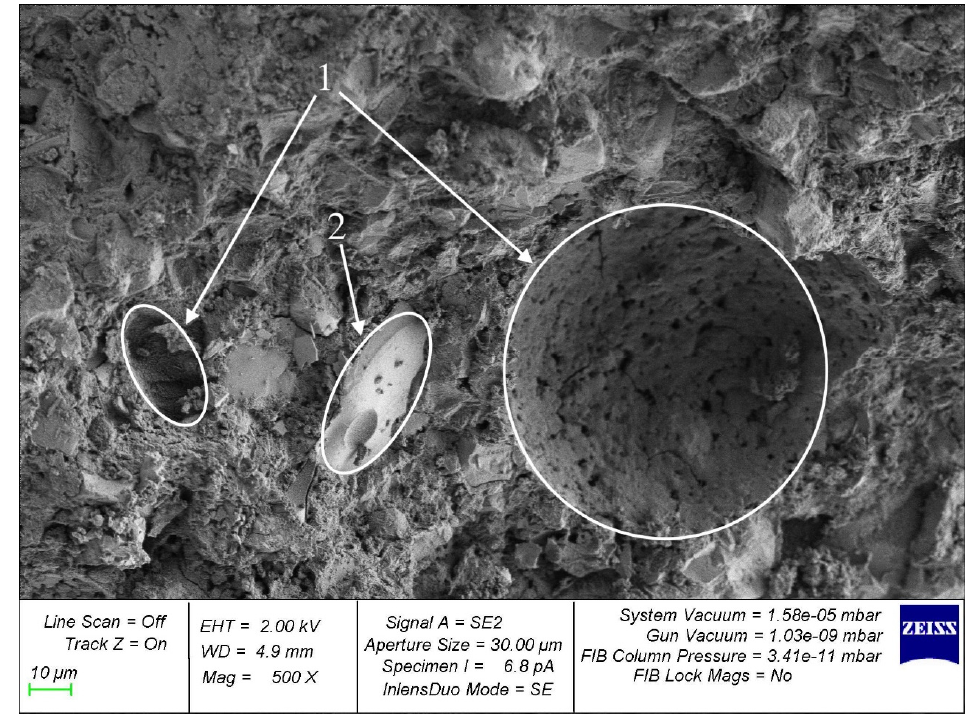
Figure 17. Sample with 12% snail shell powder dosage (1—porosity, 2—binder phase).